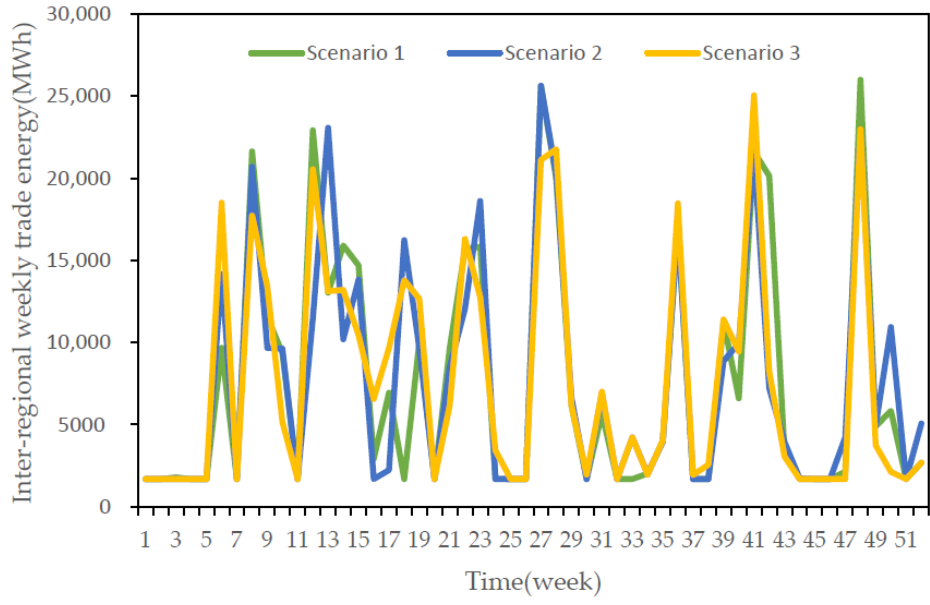
Figure 4. Cross-regional weekly trade energy.